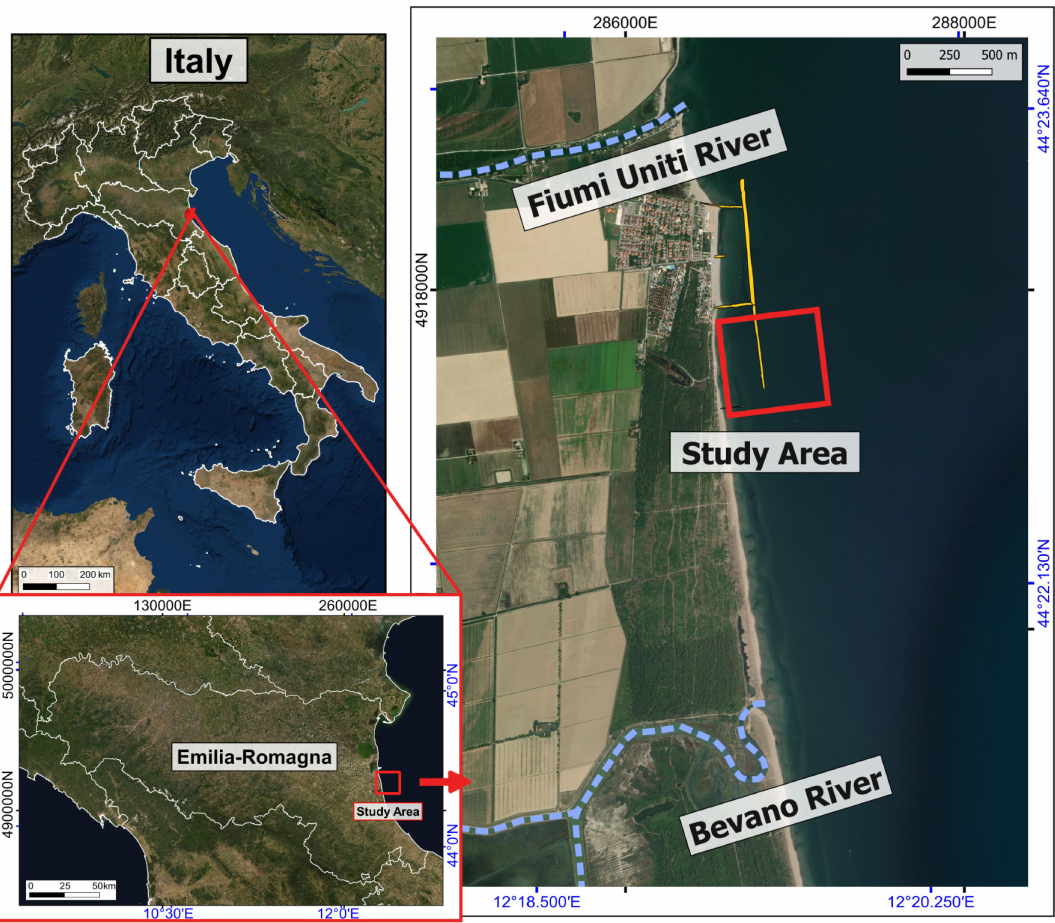
Figure 1. The study site in NE Italy, along the Emilia-Romagna coast. Projection: UTM33/WGS84. Presently, the Lido di Dante beach is artificially maintained through periodical nour- ishment. Two major interventions were carried out in 2007 and 2016, with sand volumes of about 107,100 and 122,050 m 3 , respectively [7,8]. It has been estimated that, to maintain the beach equilibrium, over 20,000 m 3 /y and 30,000–40,000 m 3 /y should be supplied for the area protected by the LCSs and the (previously) unprotected beach to the south, respec- tively [7]. Despite these nourishments, erosion is still active, and the beach is narrowing mainly in the southern stretch, where the natural dune system is subjected to overwash and overtopping during storm events